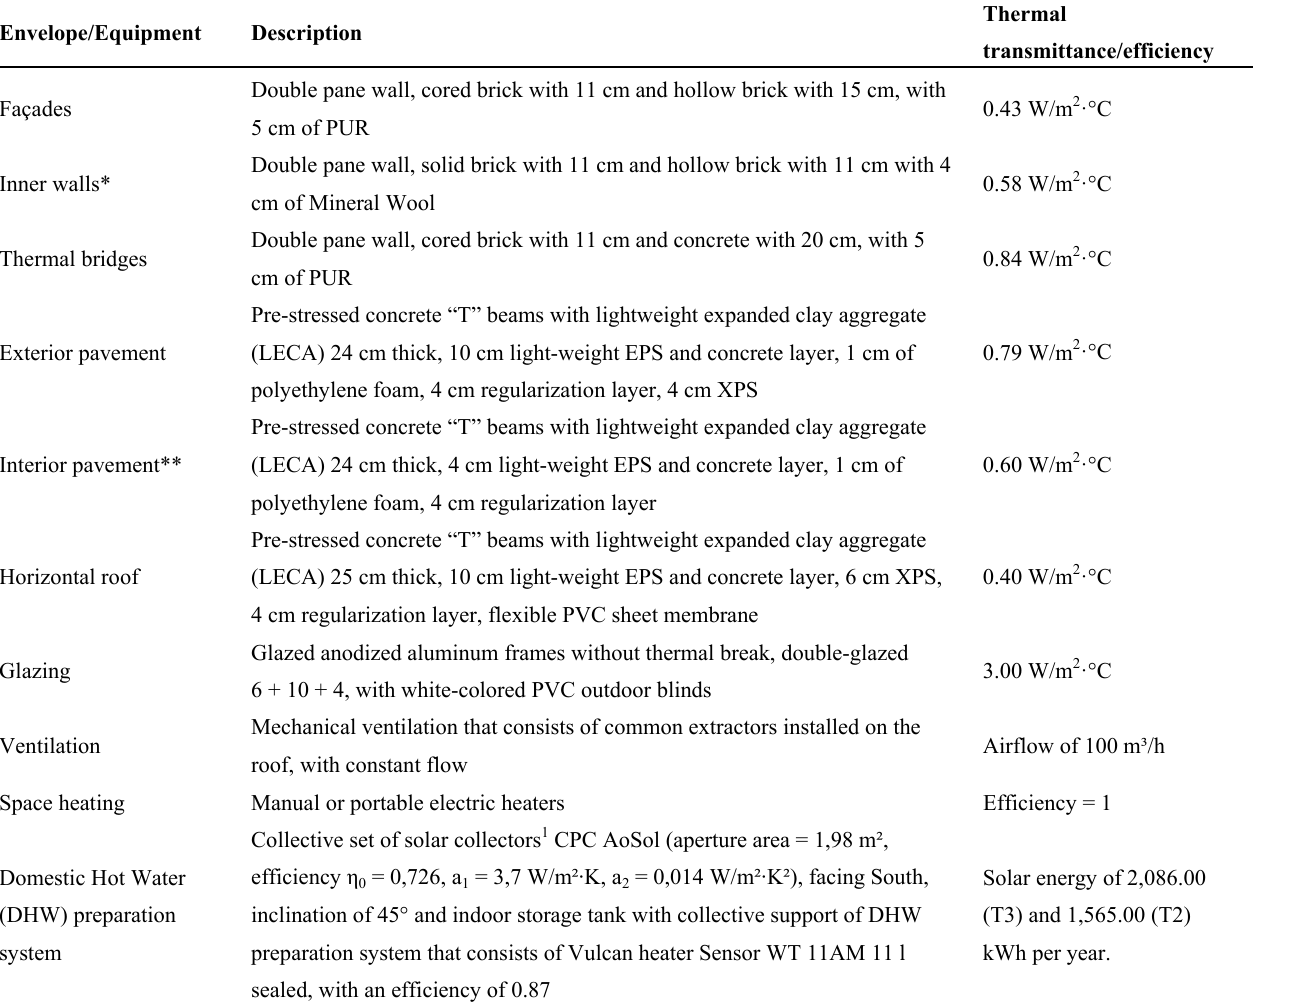
Table 1. Description of the housing envelope and